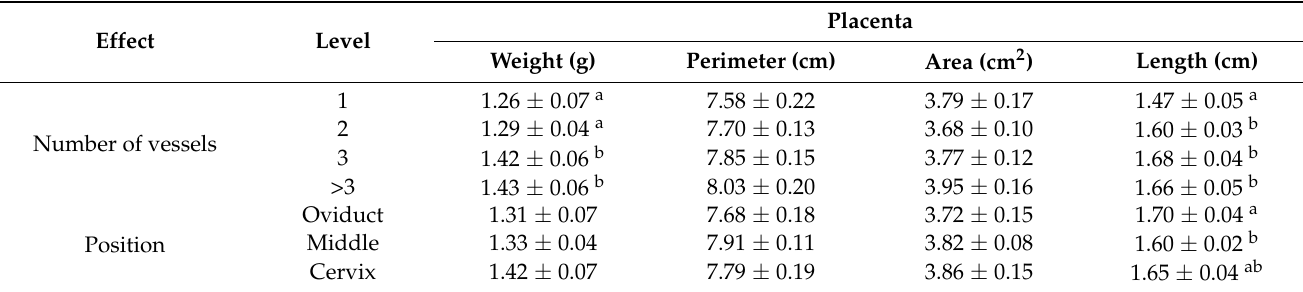
Table 5. Least square means and standard errors of the maternal placenta morphometry according to the number of vessels reaching each implantation point and the position of the foetus in the uterine